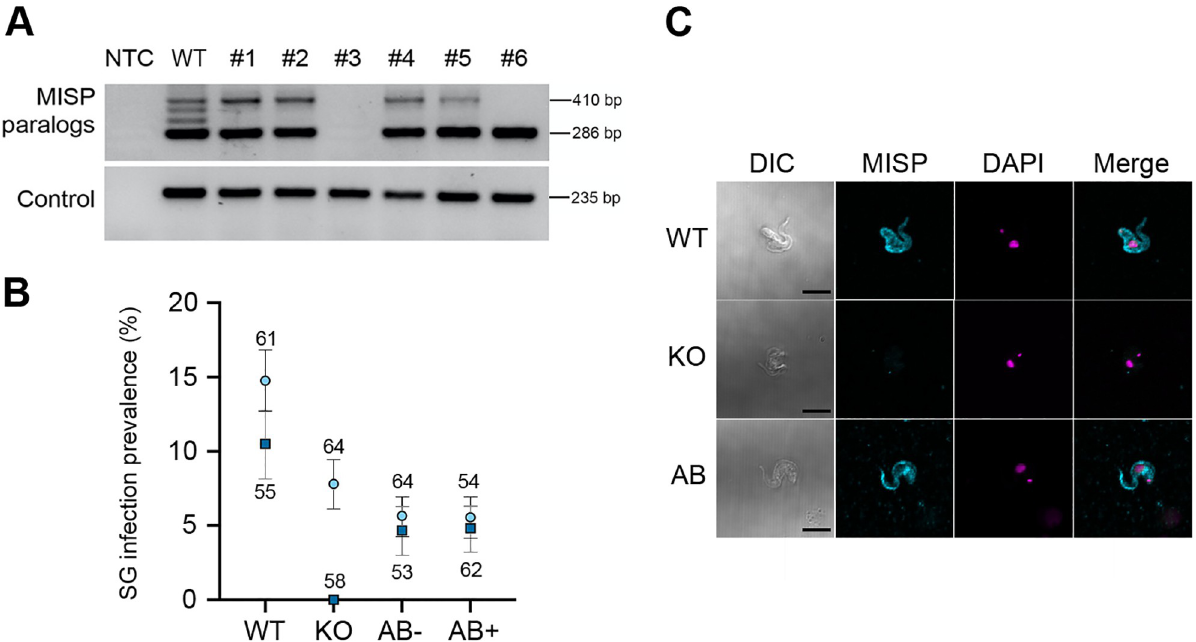
Fig 5. Characterization of MISP null mutants. ( A ) PCR genotyping of MISP KO clones (#1 to #6), wild type (WT), and negative template control (NTC) by amplification of MISP C-terminal domains (top gel); amplification of tert as control (bottom gel); relative molecular weight on the right (bp). ( B ) Infection prevalence (percentage) in tsetse salivary glands infected with either wild type (WT), MISP knock-out clone #3 (KO), MISP KO uninduced addback (AB-), and MISP KO induced addback (AB+); two biological replicates (replicate 1 (light blue circle); replicate 2 (dark blue square)); error bars indicate binomial ± SE of sample proportion (replicate 1(black), replicate 2 (gray)); sample population indicated next to each point. ( C ) Representative images of wild type (WT), MISP knock out (KO) and induced MISP addback (AB) immunostained with anti-MISP polyclonal antibodies (cyan), DAPI (magenta), merge, and differential interference contrast (DIC); scale bars = 5 μ m.